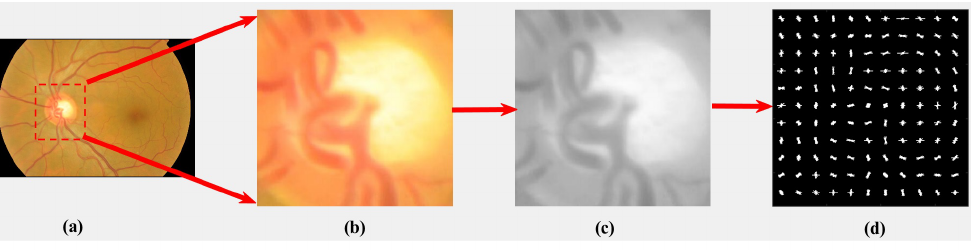
Figure 5. Stages of the HOG features. ( a ) RGB image; ( b ) cropped RGB image; ( c ) cropped gray- level image; ( d ) HOG feature